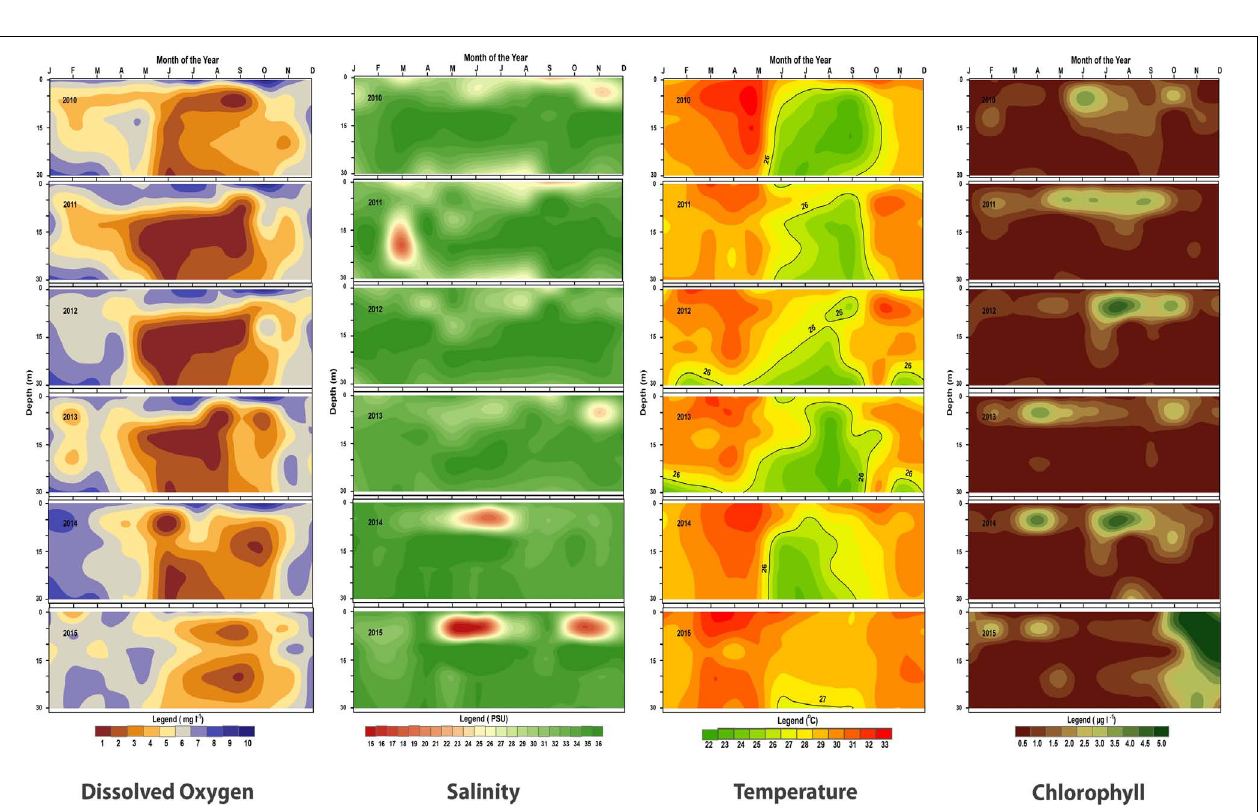
FIGURE 9 | Contour plots of monthly values of dissolved oxygen, salinity, temperature and chlorophyll-a at different depths (0–30 m) during 2010–2015 in the oil sardine fishing grounds off Kochi, southeastern Arabian Sea.